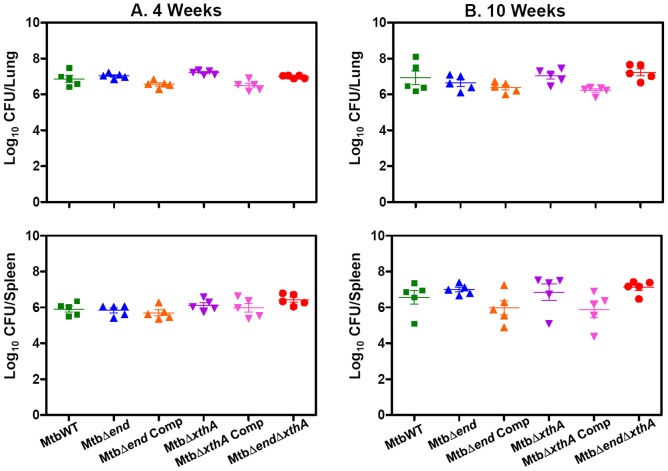
Influence of disruption of AP endonuclease(s) on the growth of M.tuberculosis in guinea pigs.The figure depicts bacillary load in the lungs and spleens of guinea pigs (n = 5) infected with wild-type M.tuberculosis, MtbΔend, MtbΔendComp, MtbΔxthA and MtbΔxthAComp and MtbΔendΔxthA at (A) 4 weeks and (B) 10 weeks post-infection. Guinea pigs belonging to all groups exhibited a comparable bacillary load in the lungs as well as in the spleen. Each data point represents the Log10 CFU value for an individual animal and the bar depicts mean (±SE) for each group.